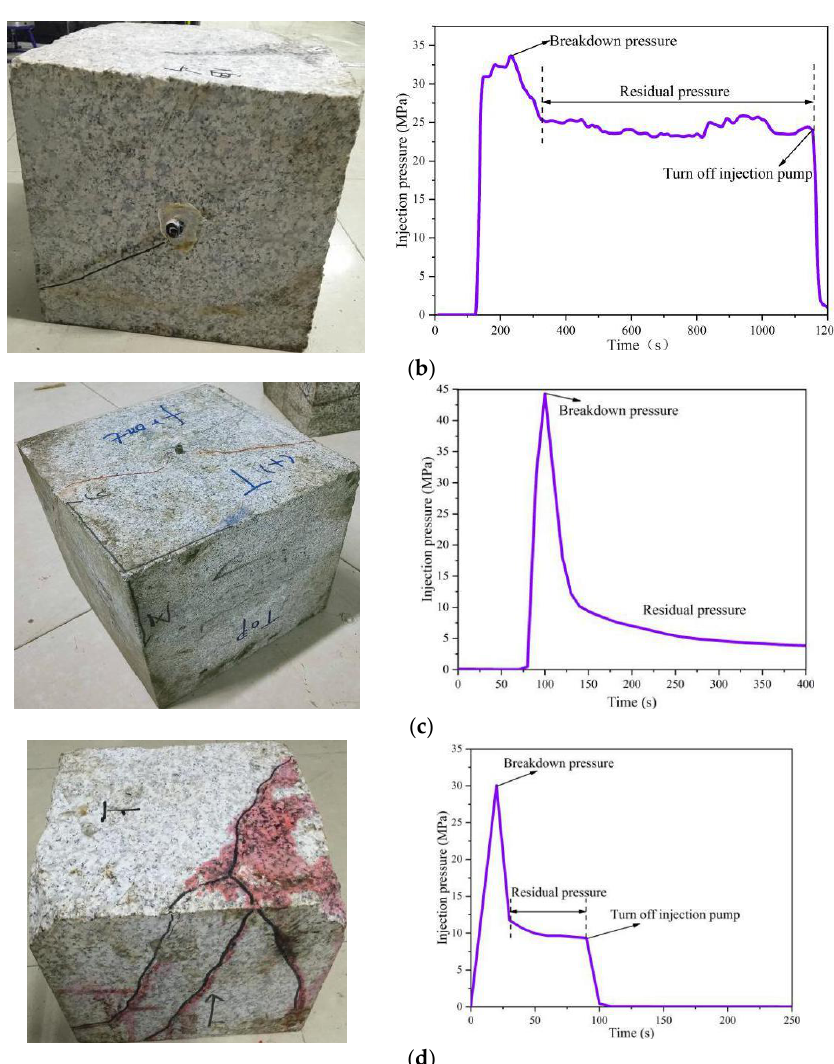
Figure 8. Fractured monzogranite samples and pressure-time curves for different injection rates. ( a ) MG-3 sample (1 mL/min), ( b ) MG-4 sample (5 mL/min), ( c ) MG-5 sample (10 mL/min), and ( d ) MG-6 sample (25 mL/min).